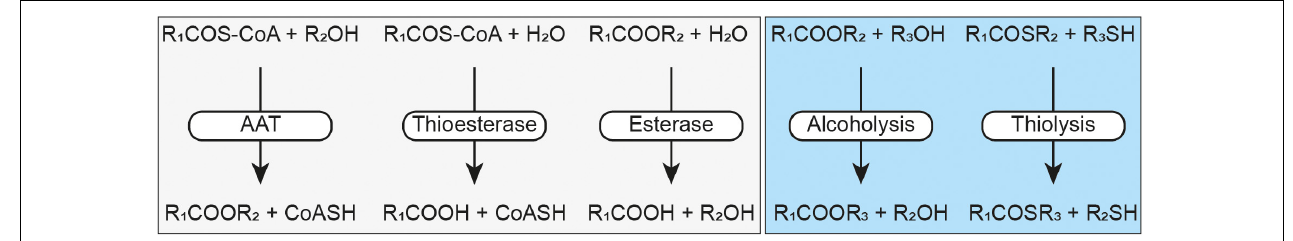
FIGURE 1 | Schematic representation of the Eat1 activities. Alcohol acyl transferase (AAT), thioesterase and esterase activities have previously been described by Kruis et al. (2017) (light gray box). Alcoholysis and thiolysis are described by this study (light blue box). An acyl-CoA is represented by RCOS-CoA, a free CoA by CoASH, an ester by RCOOR, a thioester by RCOSR, an alcohol by ROH and a thiol by RSH.